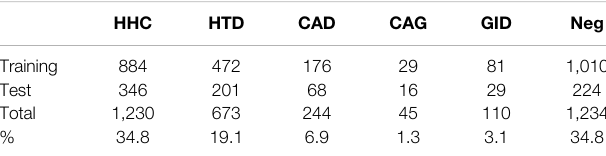
TABLE 3 | Stats for the herb RE